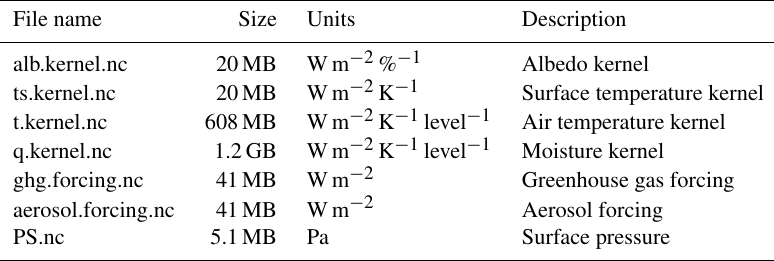
Table 3. Data files comprising the